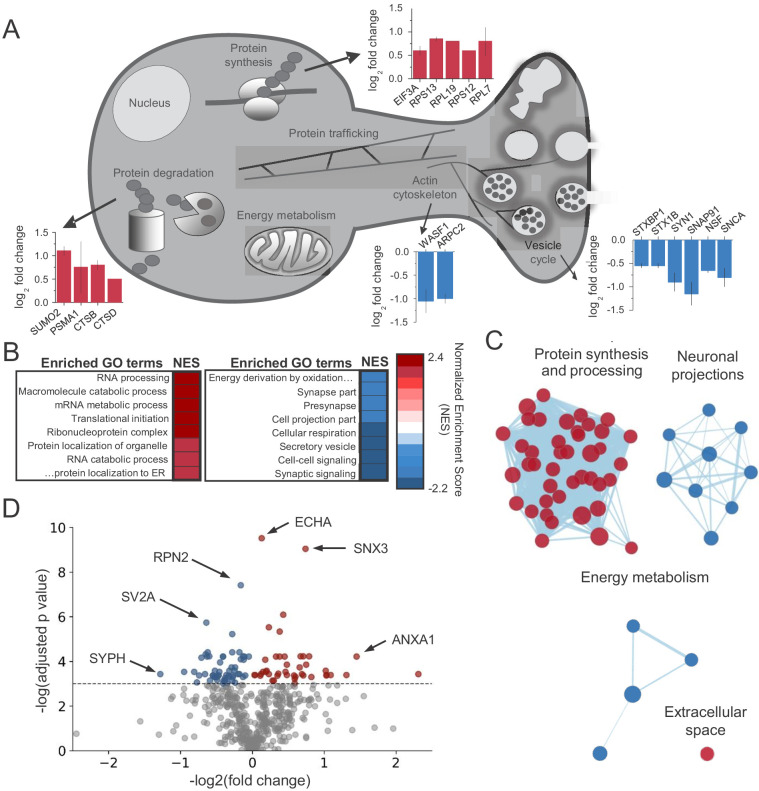
CB1activation alters the abundance of proteins linked to protein synthesis, synaptic structure/function and energy metabolism.(A) Examples of proteins that were identified in enriched GO terms and were significantly altered by CB1 activation (p<0.05). Proteins are grouped by proposed biological function and average log2 fold change is plotted. (B) List of enriched GO terms and normalized enrichment scores (NES) as identified by GSEA. Positive NES reflects overall upregulation of proteins associated with the GO term whereas negative values indicate the opposite. (C) Cluster analysis of enriched/depleted GO terms from GSEA revealed four distinct biological processes that were consistently up- or downregulated by CB1 activation. Each node represents a single GO term. Node size represents magnitude of enrichment and edge length gives degree of overlap between 2 GO terms. Color represents up (red) or downregulation (blue) of proteins associated with that GO term. See Figure 2—figure supplement 2 for examples. (D) Volcano plot of differentially expressed proteins between vehicle and CB1 activation. Red dots: differentially expressed proteins showing upregulation (adj. p<0.05 and log2 fold change >0). Blue dots: differentially expressed proteins showing downregulation (adj. p<0.05 and log2 fold change <0). six select top hits are highlighted: ECHA: trifunctional enzyme subunit alpha (mitochondrial); SNX3: Sorting nexin-3; RPN2: Subunit of the oligosaccharyl transferase; SV2A: Synaptic vesicle glycoprotein 2A; ANXA1: Annexin A1; SYPH: Synaptophysin.